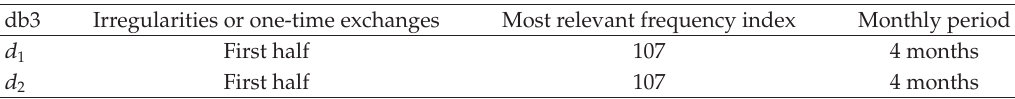
Table 3: First assumption. Relevant frequency indices of Spain INDEX after first and second periods added in the sensitivity